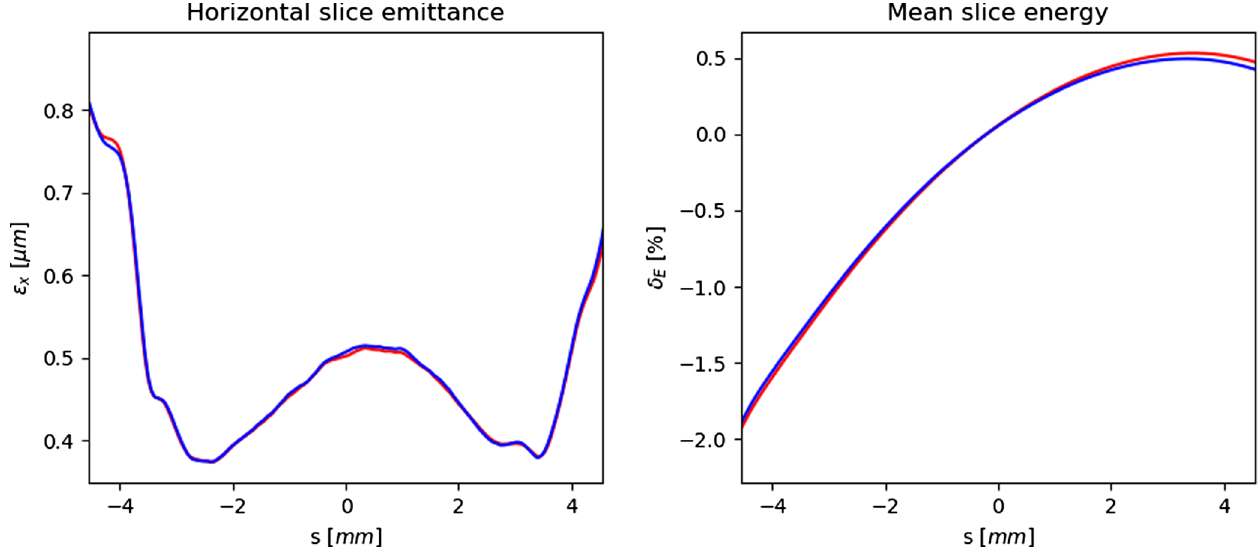
FIG. 13. Comparison of the slice parameters at position z ¼ 14 . 3 m from the cathode calculated by ASTRA (in blue) and O celot (in